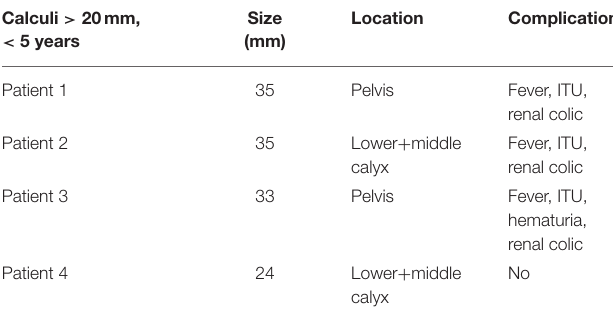
TABLE 4 | Patients under 5 years old with lithiasis >